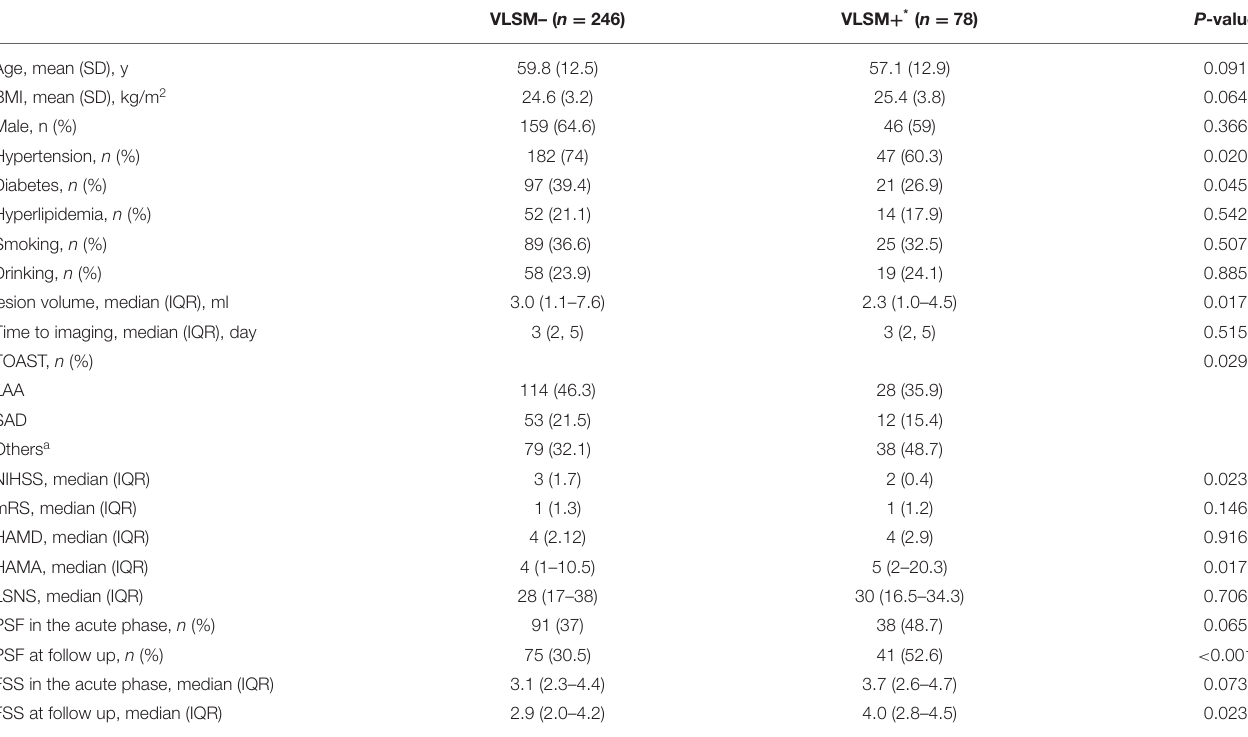
TABLE 2 | Baseline characteristics between VLSM + and VLSM–